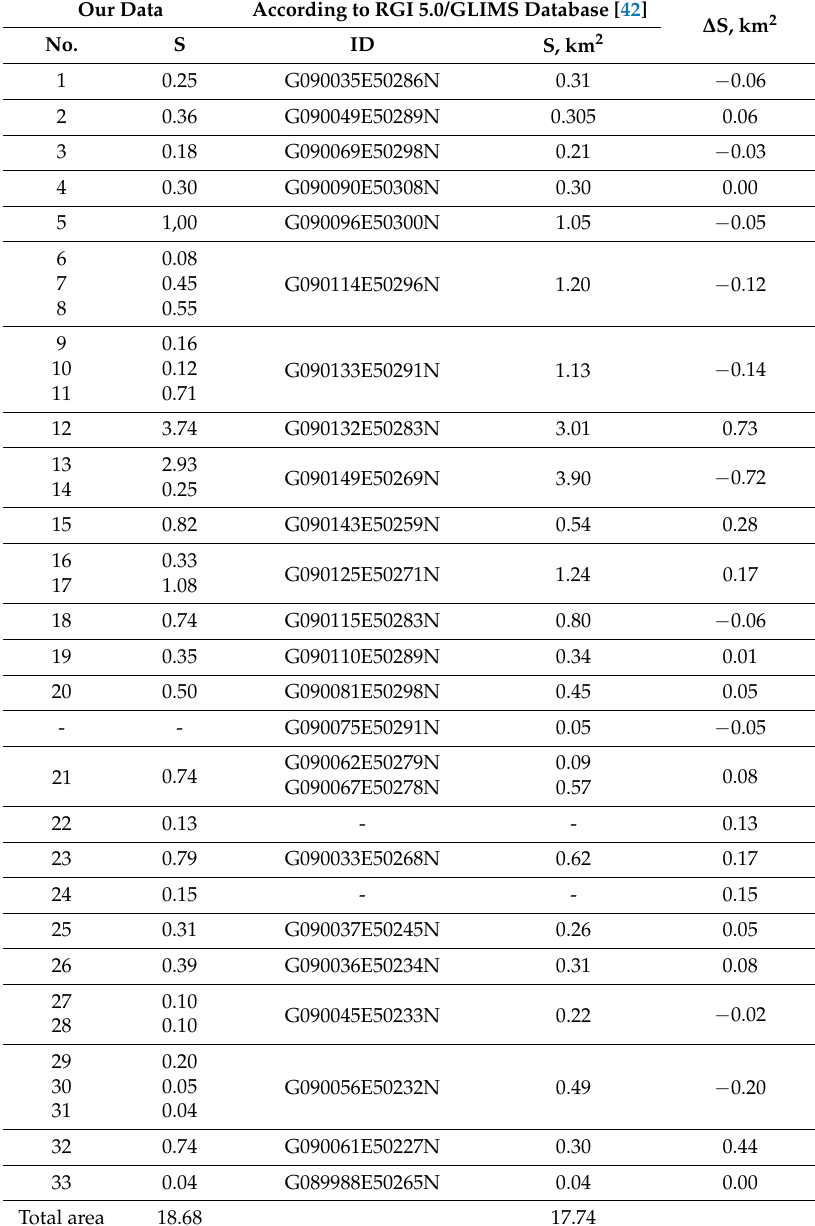
Table 6. Areas of the glaciers of Mongun-Taiga according to our estimation with the values of the RGI 5.0/GLIMS database